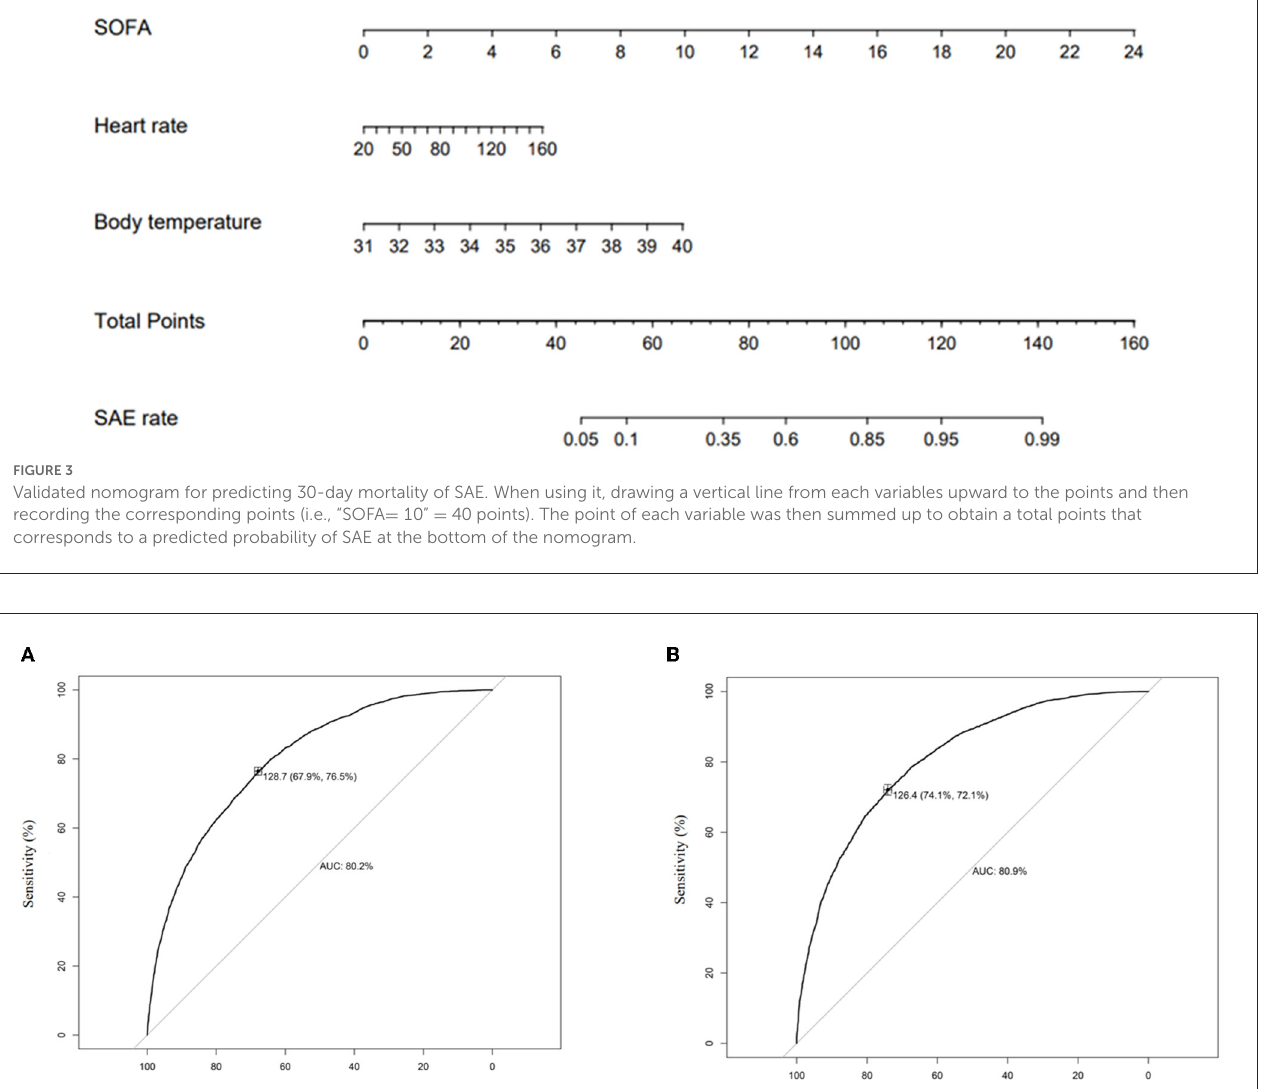
SAE (18.8 vs. 8.9%, p < 0.001). Patients with SAE had a longer length of ICU stay (4.94 ± 5.50 vs. 3.30 ± 4.30 days, p < 0.001) and hospital stay (12.05 ± 12.37 vs. 9.06 ± 8.97 days, p = 0.000). A previous study [16] reported the 28-day mortality in SAE and non-SAE groups (45.95 vs. 17.82%, p < 0.01). The average of SOFA was approximately